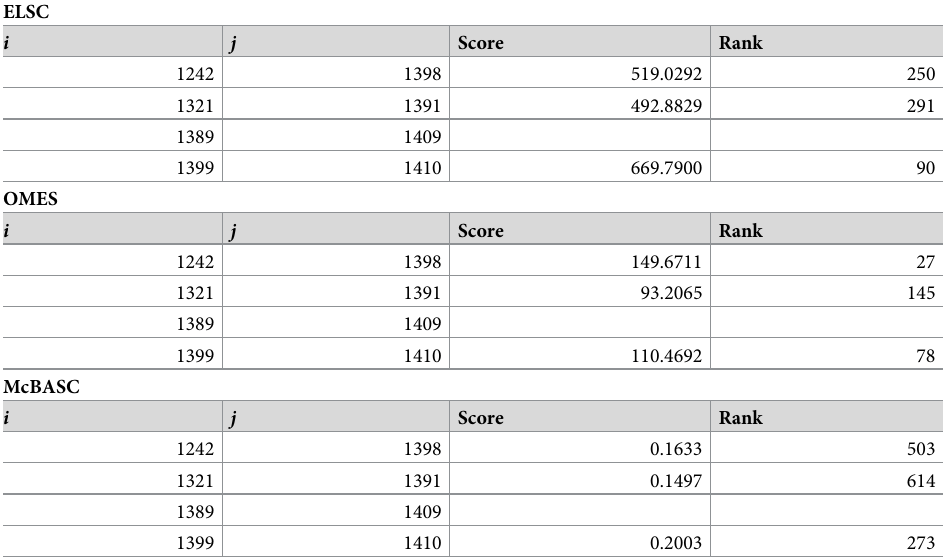
The scores and rank for given for coupled positions ( i , j ) for each covariance algorithm is shown with the rank representing the coupled positions’ score with respect to all the coupled positions in its covariance algorithm and MSA. For this table, all ranks are out of 26797 coupled positions. The scrambled values for ELSC, OMES and McBASC are 27.2040, 2.2326, and 0.1165